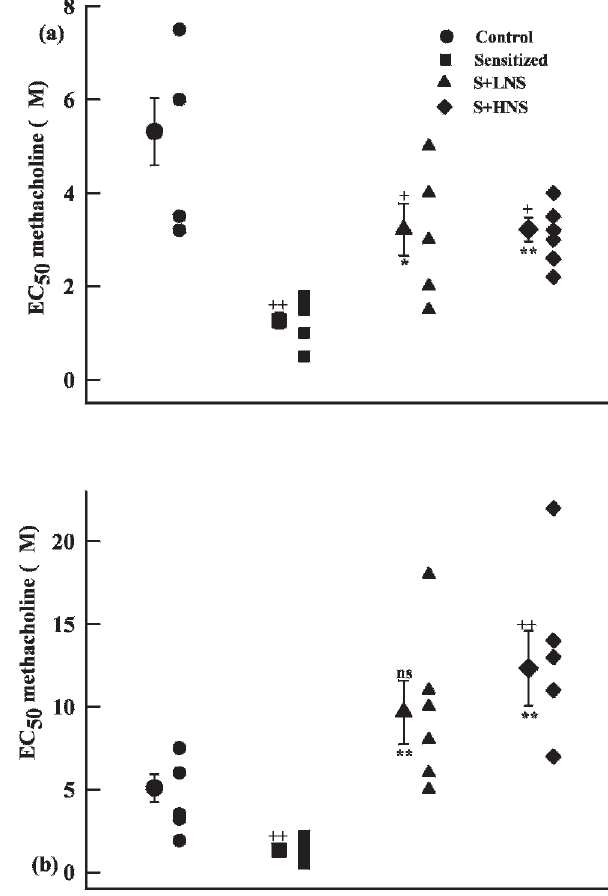
Figure 3 - Individual values and the mean ¡ SEM (larger symbols with bars) of the tracheal response to methacholine (EC 50 ) in tissues either non incubated treated (a) or treated with 0.25 g% N. sativa extract (b; for each group, n =7). Statistical differences between the control and different groups: + ; p , 0.05, ++ ; p , 0.01. Statistical differences between the S + LNS and S + HNS vs. sensitized group: **: p , 0.01. There was no significant difference in the effects of the two different concentrations of